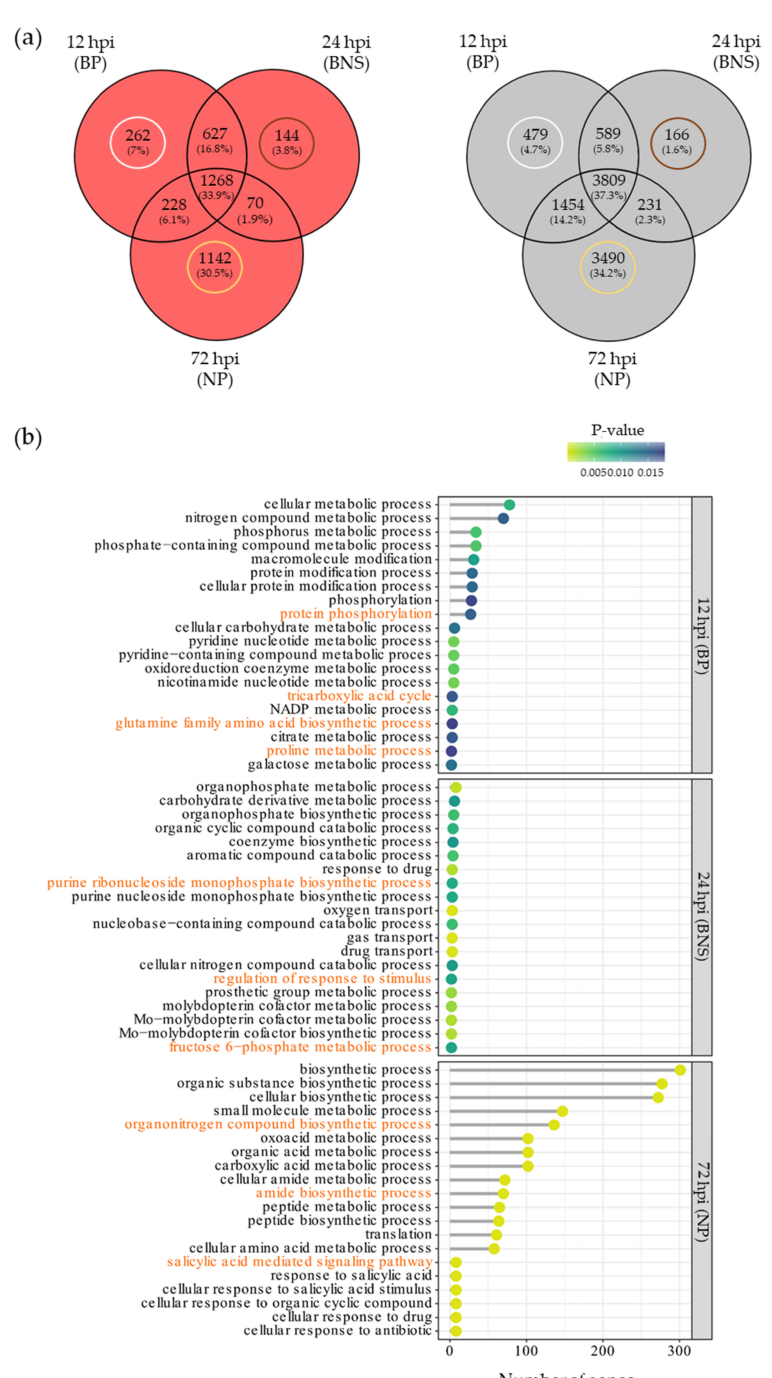
Figure 5. Chickpea unique responses at each of the phases reveal similar and different responses ob- served in other models. ( a ) Venn diagrams showing the number of common and unique